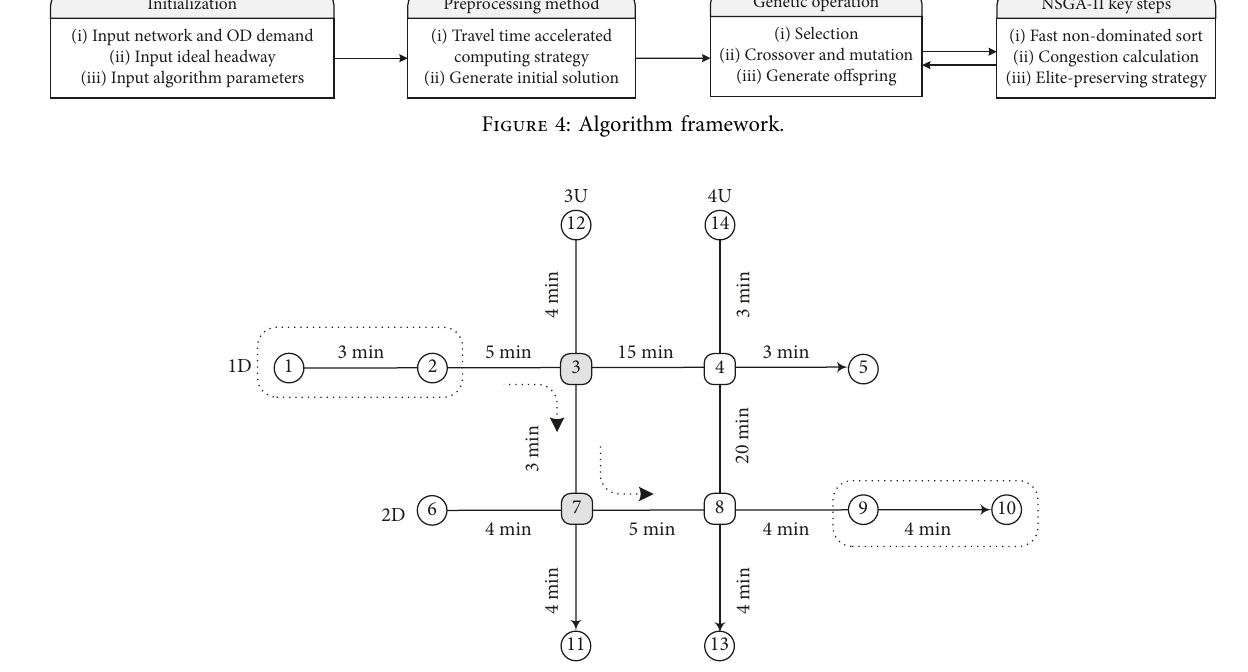
Figure 5: Illustration of the running time on each segment. Table 3: Feasible route of OD demand from stations 1 to 10.